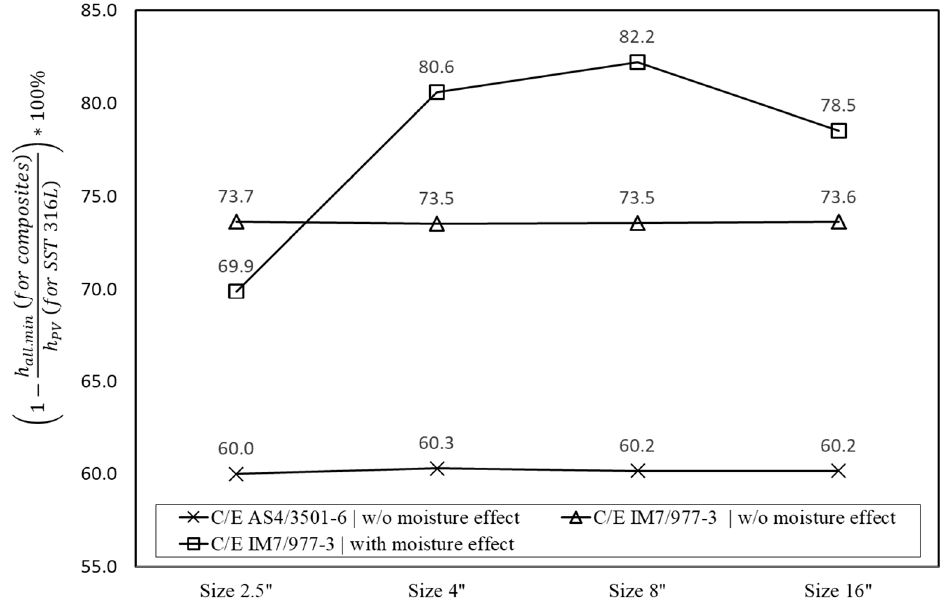
Figure 9. The reduction of minimum allowable thickness for composite PVs relative to SST 316L PV. The figure shows the dependency between the PV size and the inclusion of moisture effects.